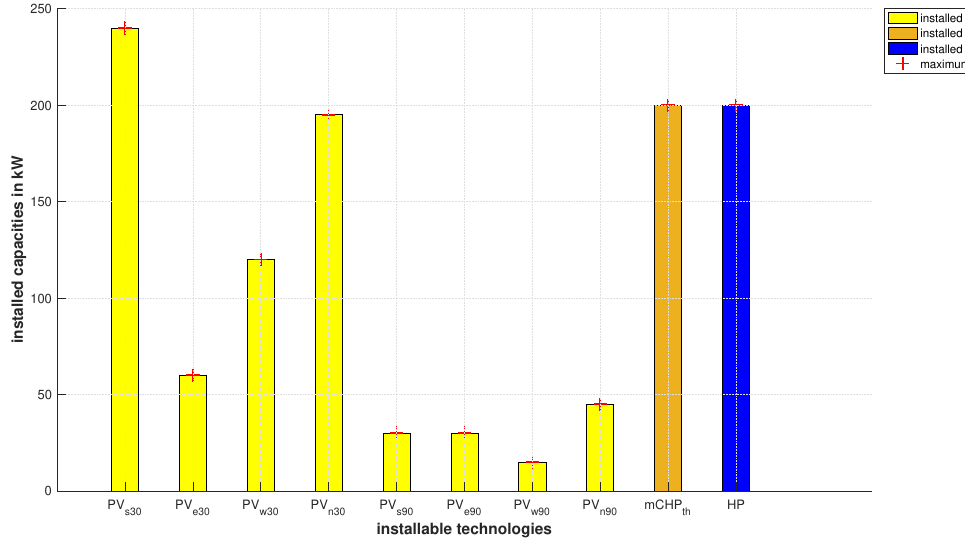
Figure 7. Installed local energy capacities for the energy cooperative business